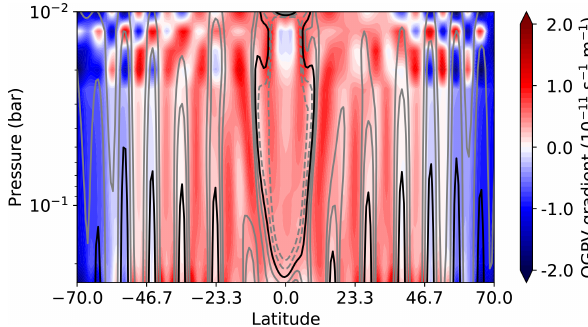
Figure 16. Zonal-mean latitude–height section of ∂Q/∂y (s − 1 m − 1 ) and zonal-mean zonal wind (ms − 1 ) in a numerical sim- ulation of Jupiter’s weather layer, from Young et al. (2019a). Data correspond to run B of Young et al. (2019a) and were averaged over the last 100d of the equilibrated run. Shading represents ∂Q/∂y , and the line contours represent zonal-mean zonal velocity u , shown for − 10, − 5, + 5 and + 10ms − 1 in grey and 0ms − 1 in